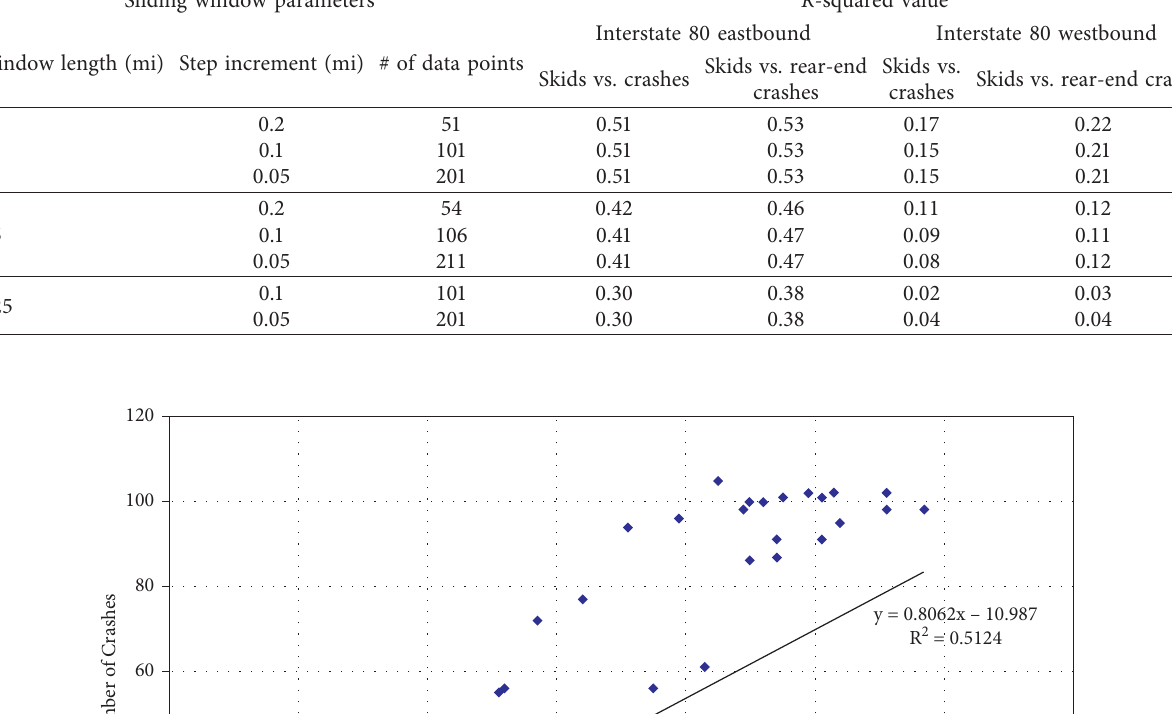
Table 4: R -squared values for different regression analyses on Interstate 80 based on various sliding window parameters. Sliding window parameters